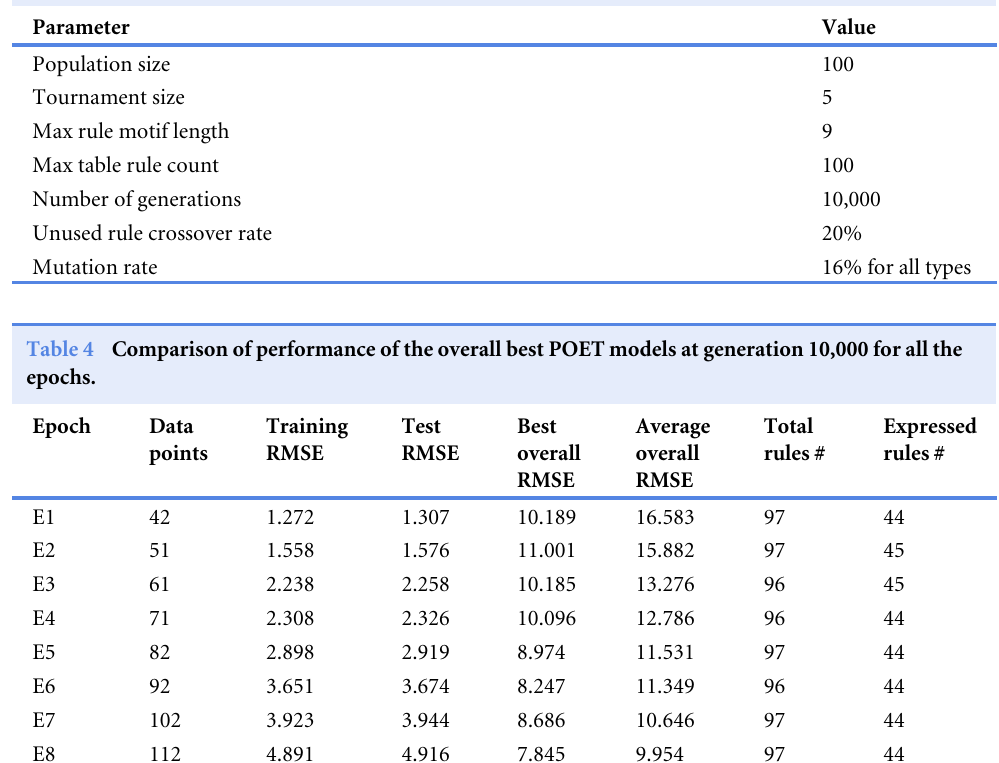
Table 3 Experimental parameters used for the case study.